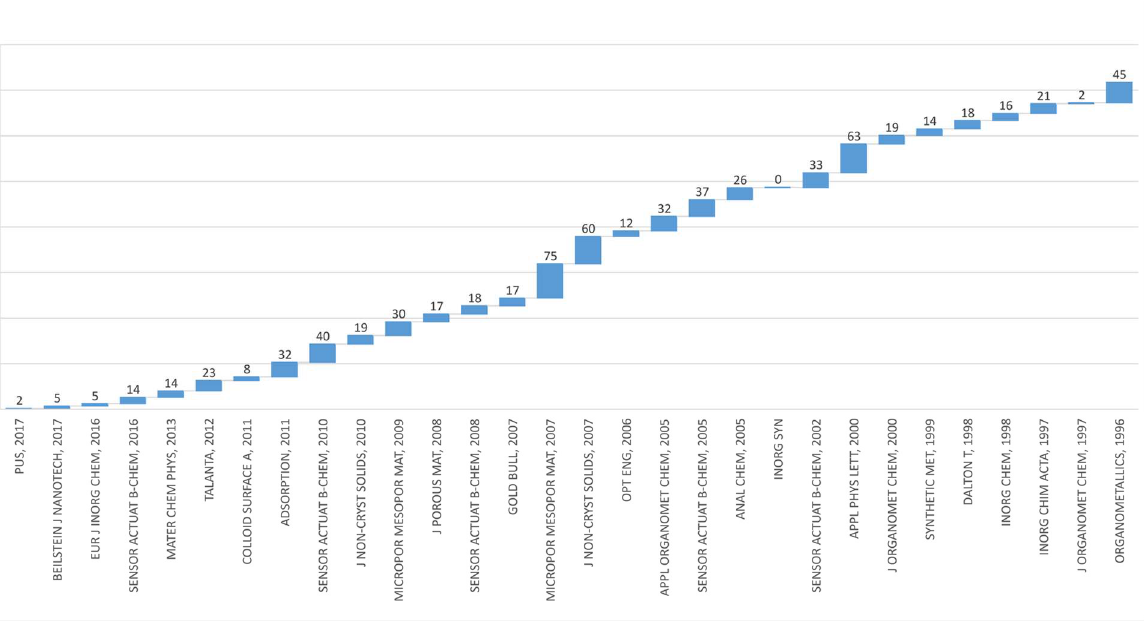
Table 3. Productivity of the authors and collaborators (coauthors). Data separated by